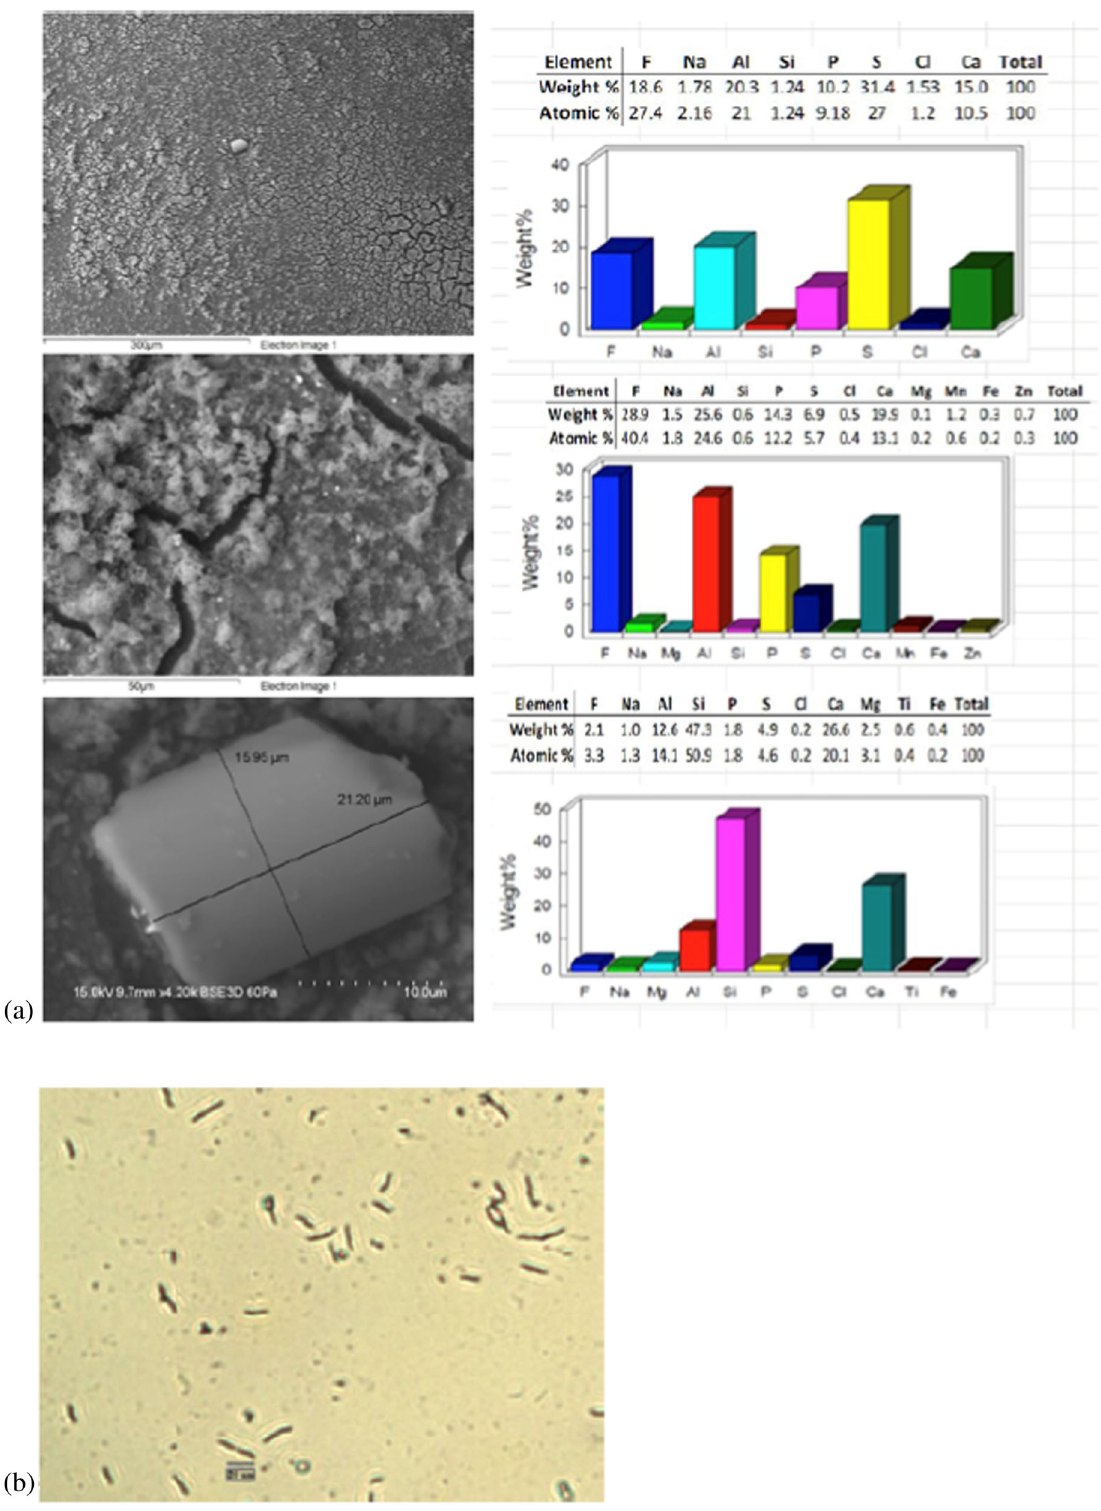
Fig. 5 Microscopic image of gram-negative bacteria presented on the RO membrane. a SEM images of fouled membrane surfaces at different magni fi cations; scale bars indicate 300, 50 and 10 μ m lengths and the crystal is measured at 15.95 x 21.20 μ m. ( b ) Relative weight percent by element from different locations of the fouling layer as determined by EDAX. ( c ) Optical microscope image of gram-negative bacteria presented on the RO membrane. The morphology of the bacteria was determined to be mainly spherical cocci, fi lamentous and rod- shaped organisms. 19 Copyright Industrial Water